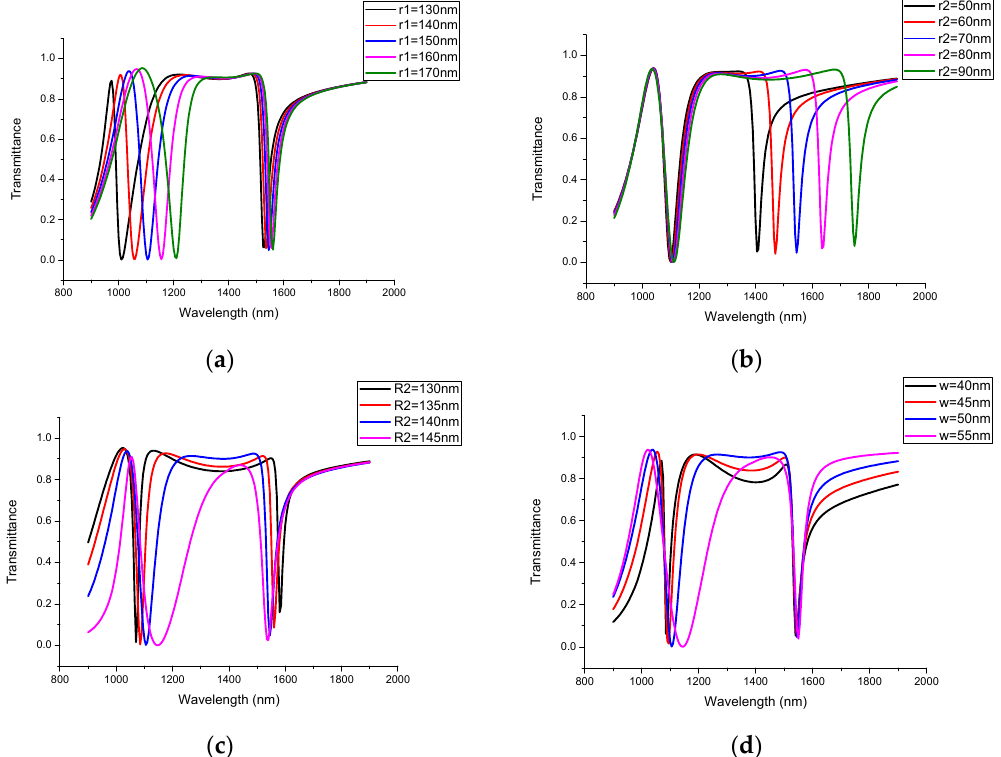
Figure 8. ( a ) Transmission spectrum of di ff erent lengths of the long axis of the inner elliptical resonator r 1 ; ( b ) Transmission spectrum of di ff erent lengths of the short axis of the inner elliptical resonator r 2 ; ( c ) Transmission spectrum of di ff erent lengths of the short axis of the outer elliptical resonator R 2 ; ( d ) Transmission spectrum of di ff erent widths of the MIM waveguide w .